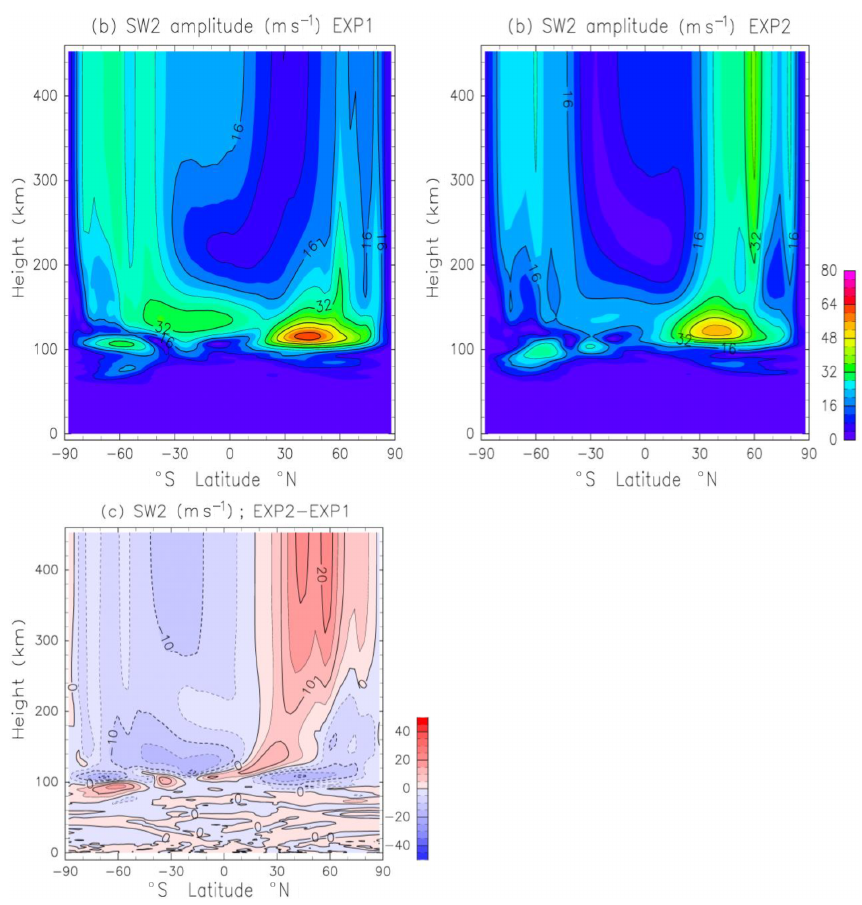
Figure 5. (a) Height–latitude distribution of the zonal-wind component of the SW2 amplitude in June obtained by EXP1. Units are meters per second. (b) As in (a) except for EXP2. (c) Zonal-wind difference between EXP1 and EXP2